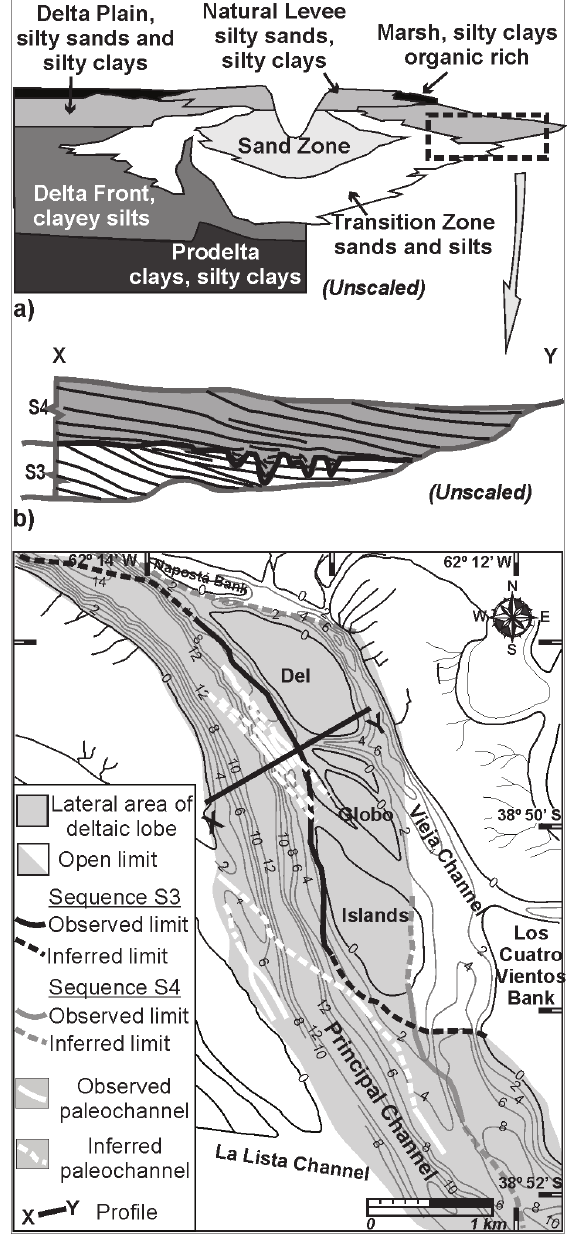
Fig. 6 - Correlation of the sedimentary structures of sequences S3 and S4 with a model of deltaic system. a) Deltaic sequences (Fisk 1961); b) representative schematic profile of the study area. Subbottom distribution and limits of S3 and